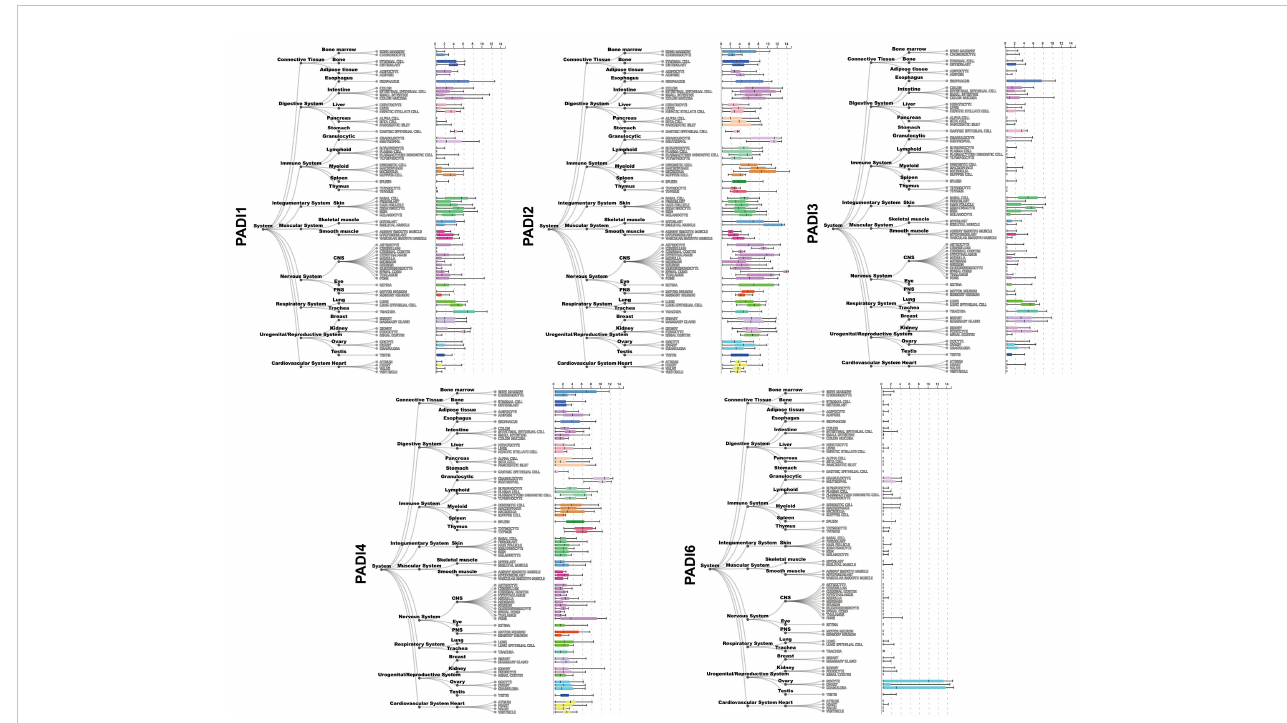
FIGURE 2 Geneexpressionof PADI1 ~ PADI4 indifferent human tissues.Gene expressiondata isprovidedbyARCHS 4